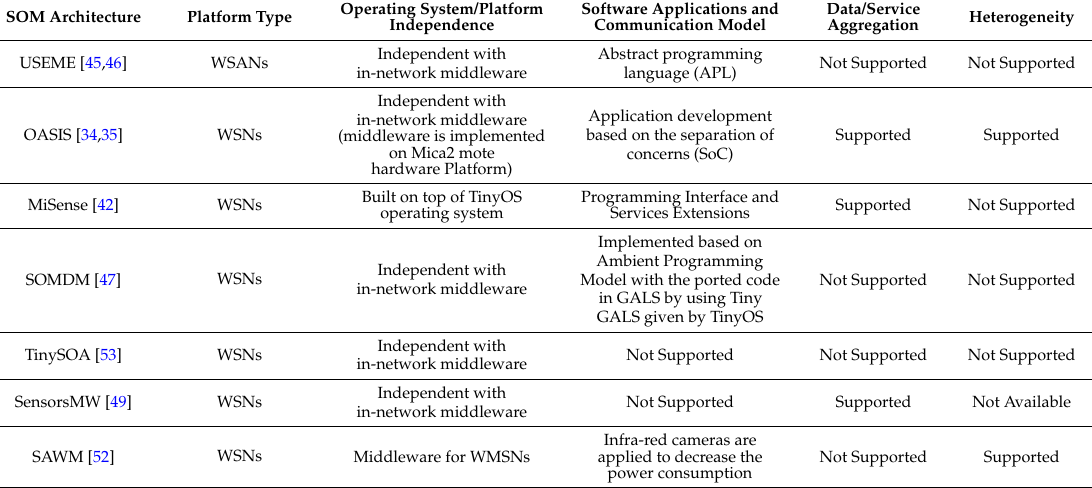
Table 2. Comparative Analysis of Service-Oriented Middleware Architectures for